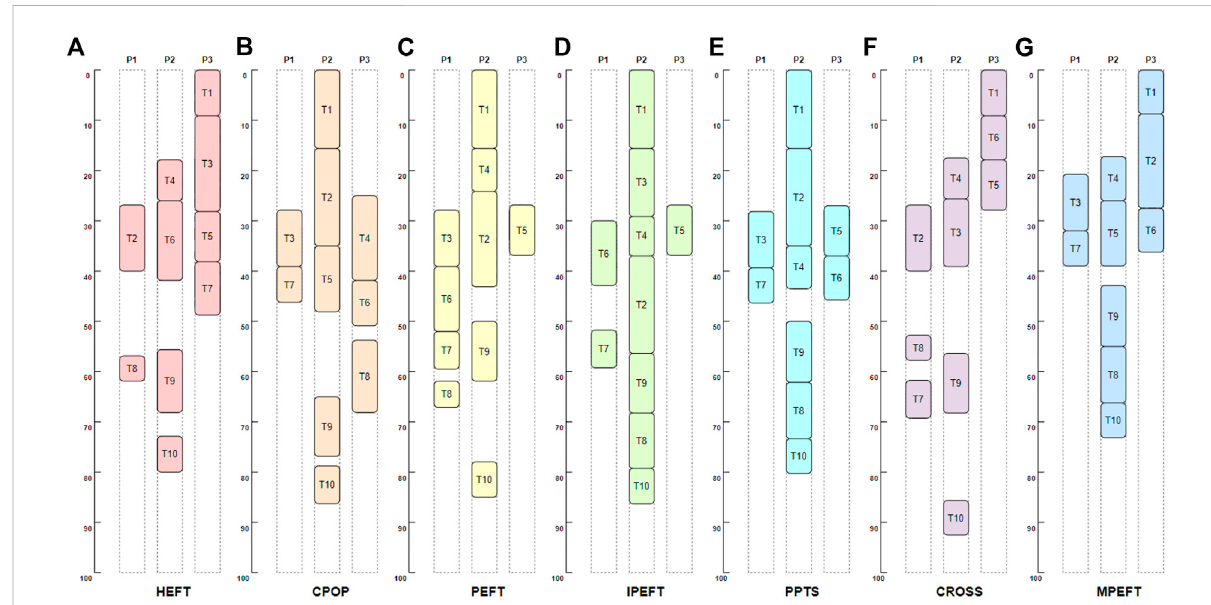
FIGURE 3 Schedules of the sample DAG in Figure 2 with (A) HEFT (makespan = 80), (B) CPOP(makespan = 86), (C) PEFT (makespan = 85), (D) IPEFT (makespan = 95), (E) PPTS (makespan = 80), (F) CROSS(makespan = 93) and (G) MPEFT (makespan =